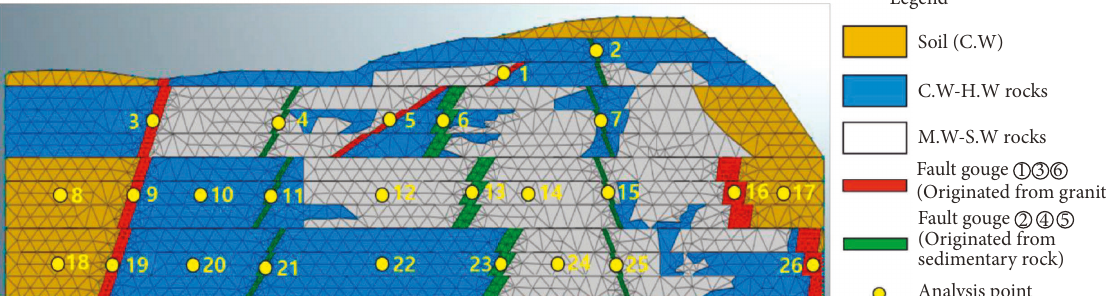
Figure 4: Distribution of the analysis points (yellow circles) in the slope, which span the various materials throughout the slope (soil, fault gouge in granite and sedimentary rock, and H.W. and M.W. sedimentary